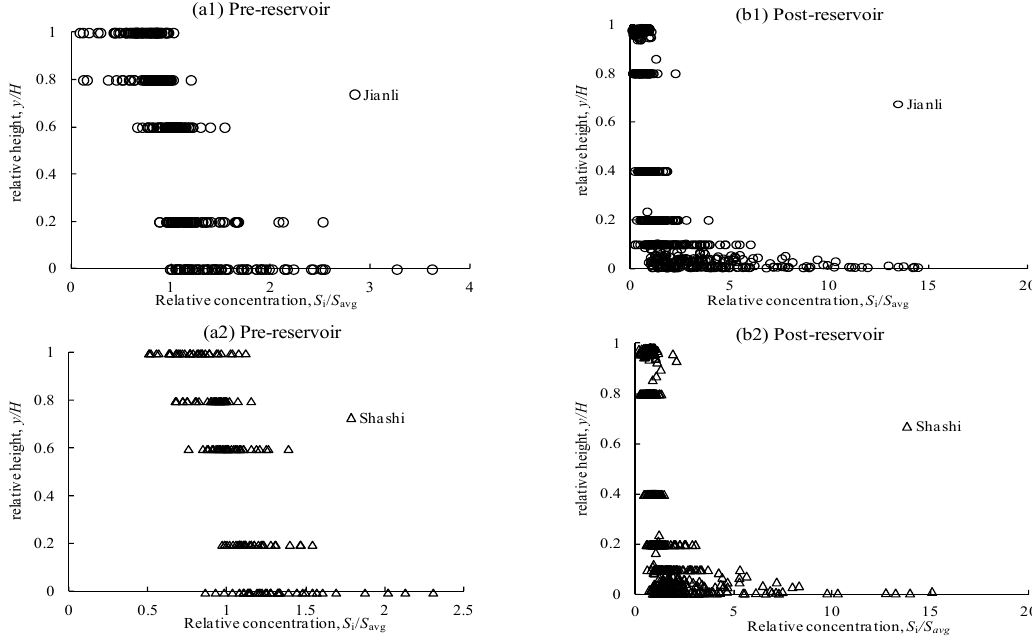
Figure 2. Vertical distributions of sediment concentrations at Shashi and Jianli hydrological stations; data measured before ( a ) and after ( b ) the Three Gorges Dam (TGD) operation in 2003. S i is the measured concentration of the vertical profile (kg/m 3 ), and S avg represents the vertical averaged concentration (kg/m 3 ).